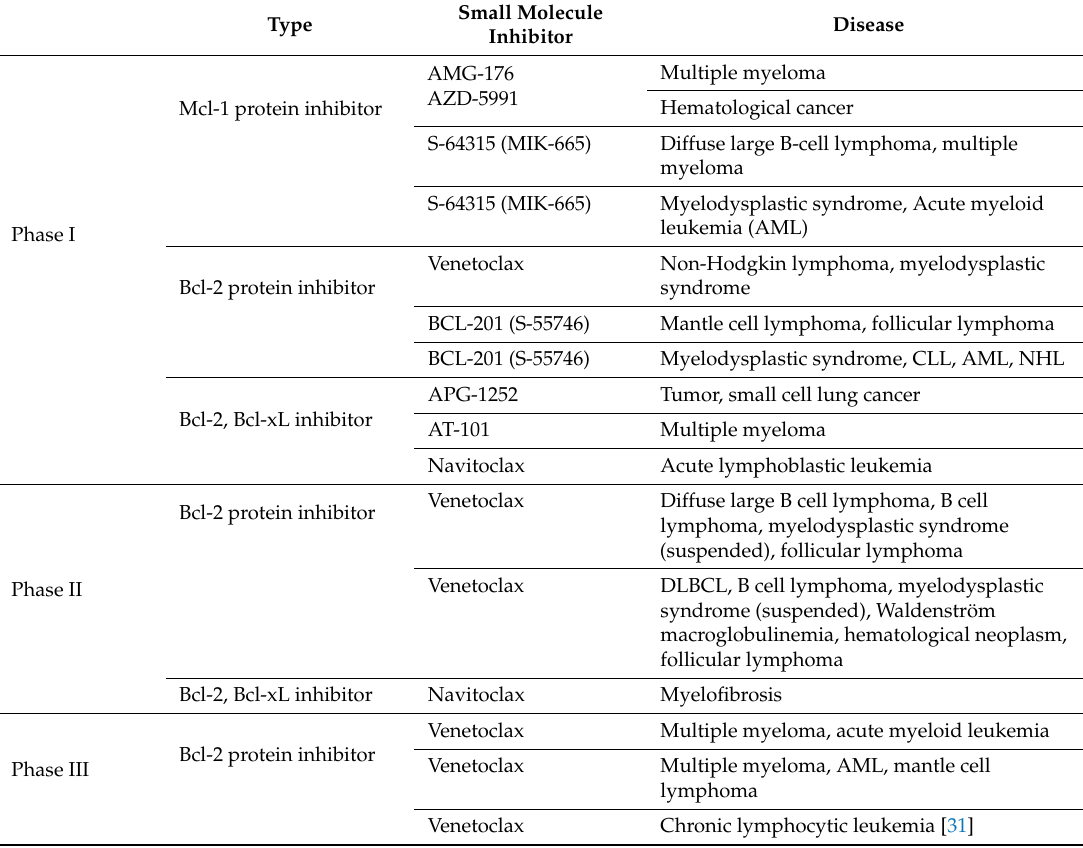
Table 6. Small molecules targeting Bcl-2-family proteins in clinical development [89].